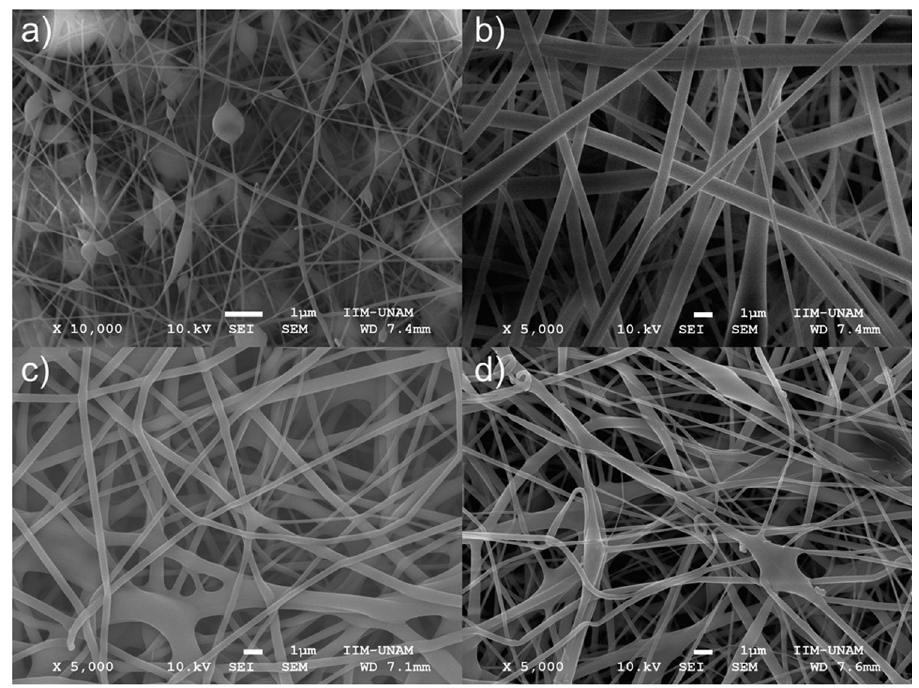
Figure 2: SEM micrographs of PVA/SC fi brous sca ff olds. ( a ) PVA/SC0 ( 10,000 ×) ; ( b ) PVA/SC1 ( 5,000 ×) ; ( c ) PVA/SC2 ( 5,000 ×) ; and ( d ) PVA/SC3 ( 5,000 ×) .